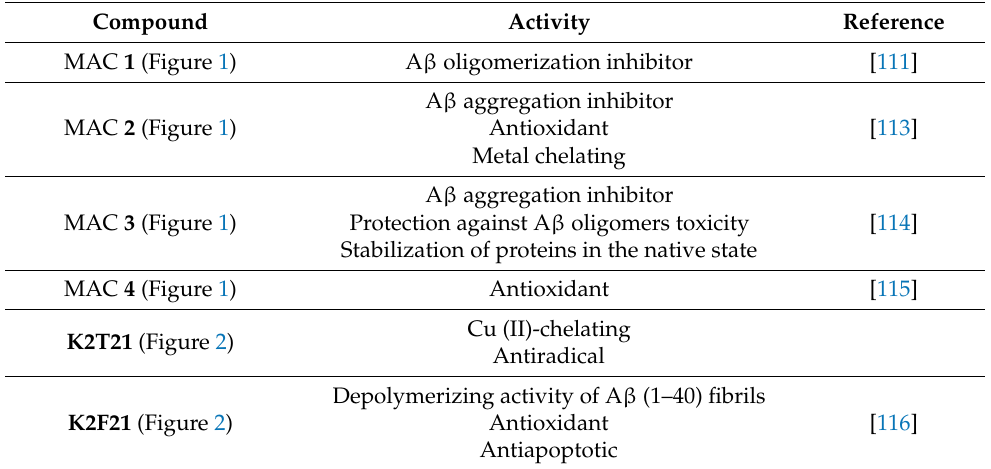
Table 1. Summary of biological activities of compounds showed in Figures